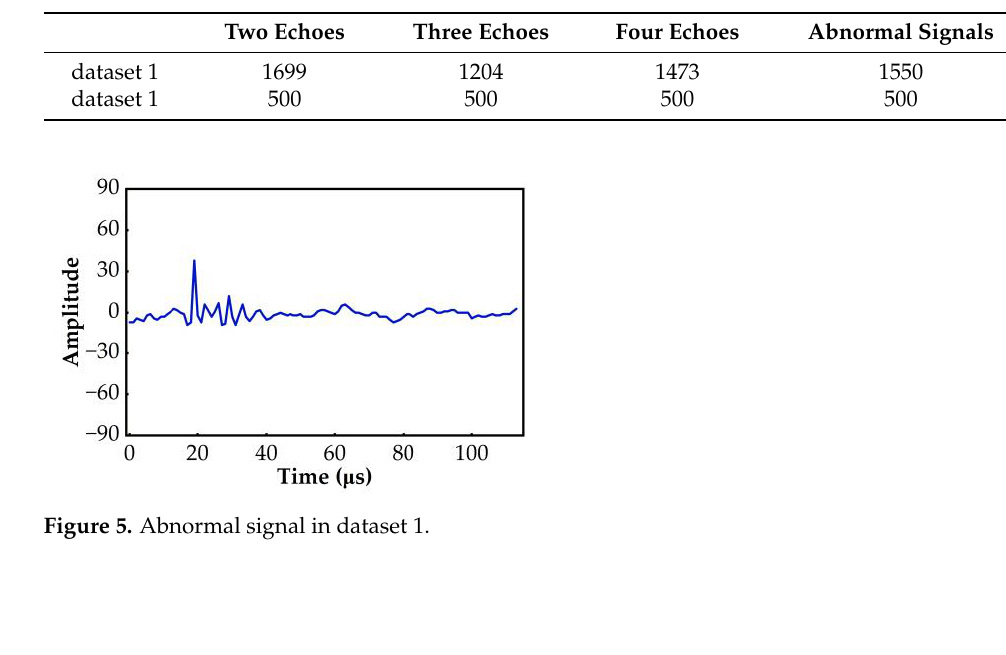
Table 3. The number of samples in the dataset.